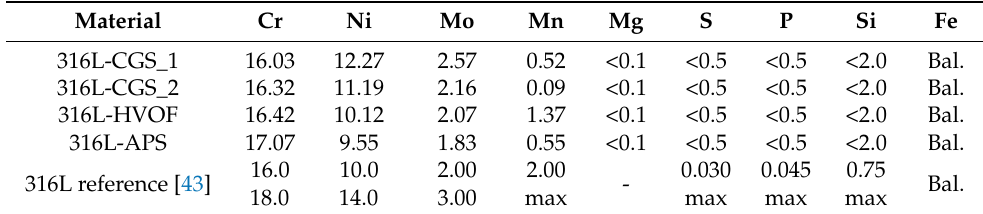
Table 2. Chemical composition of the 316L feedstock powders. wt.%.